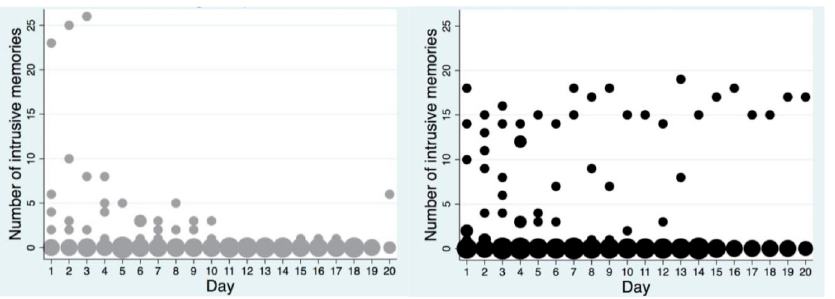
Fig 4. Frequency scatter graphs of the number of intrusive memories per day recorded in the intrusion diary during the intervention period for patients who returned the diary in each condition (the left graph depicts the PE group and the right the control condition). The circle size illustrates the number of participants who reported the indicated number of intrusive memories for each day.